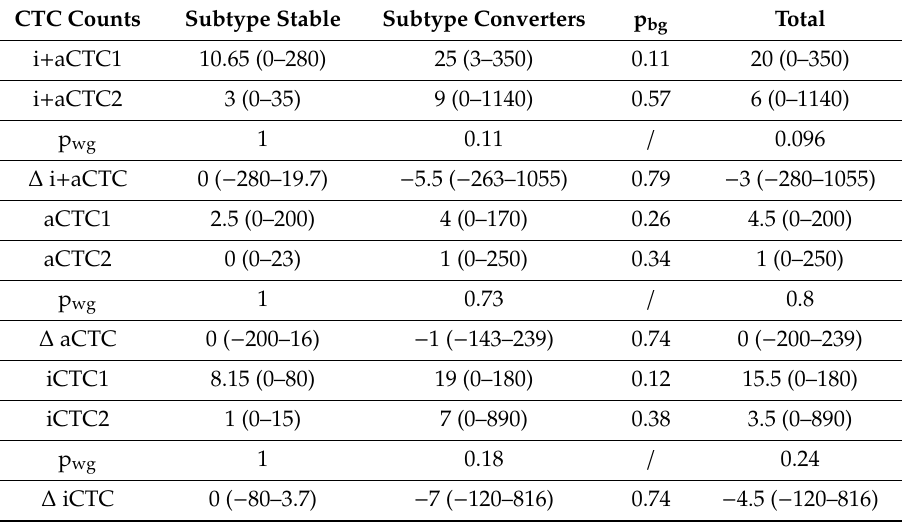
Table 2. Circulating tumor cells (CTC)